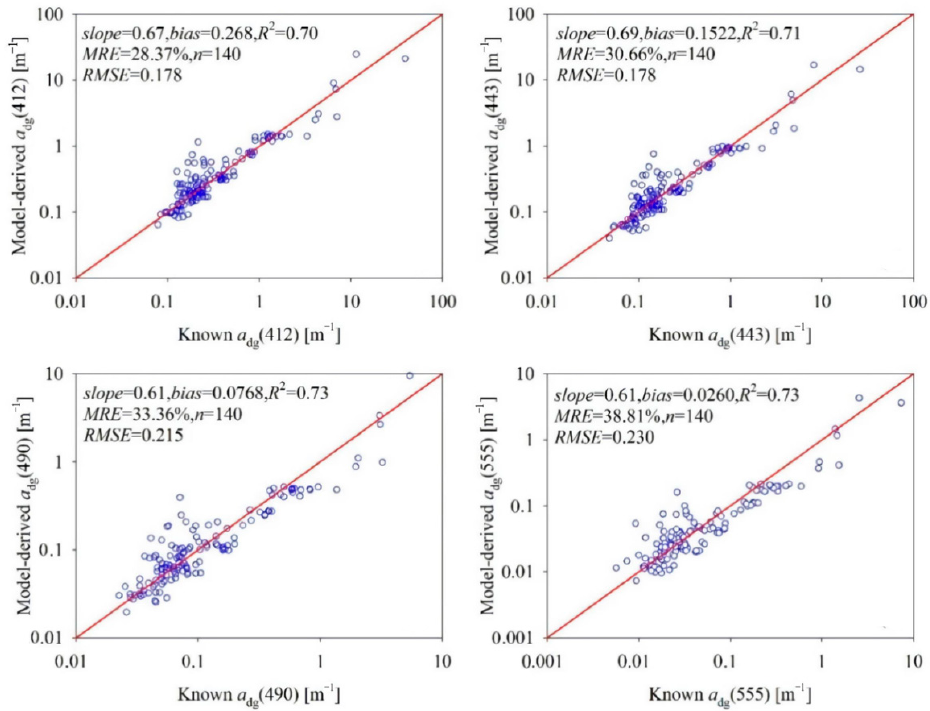
Figure 4. Accuracy evaluation of the TAA model in a dg ( λ ) retrieval in the Yellow Sea and East Sea of China.